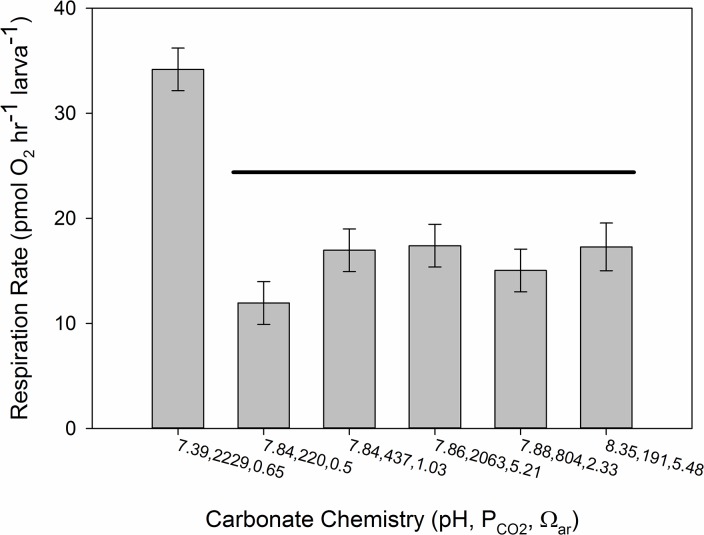
Comparisons Among Respiration Treatments.Respiration rates presented on a bar graph showing pairwise comparisons across all treatments, with the common line over values representing no significant difference. Error bars are standard errors. Note that values are arranged in increasing pH along the x-axis, and PCO2 and Ωar are included for each treatment. All values are in units previously noted.